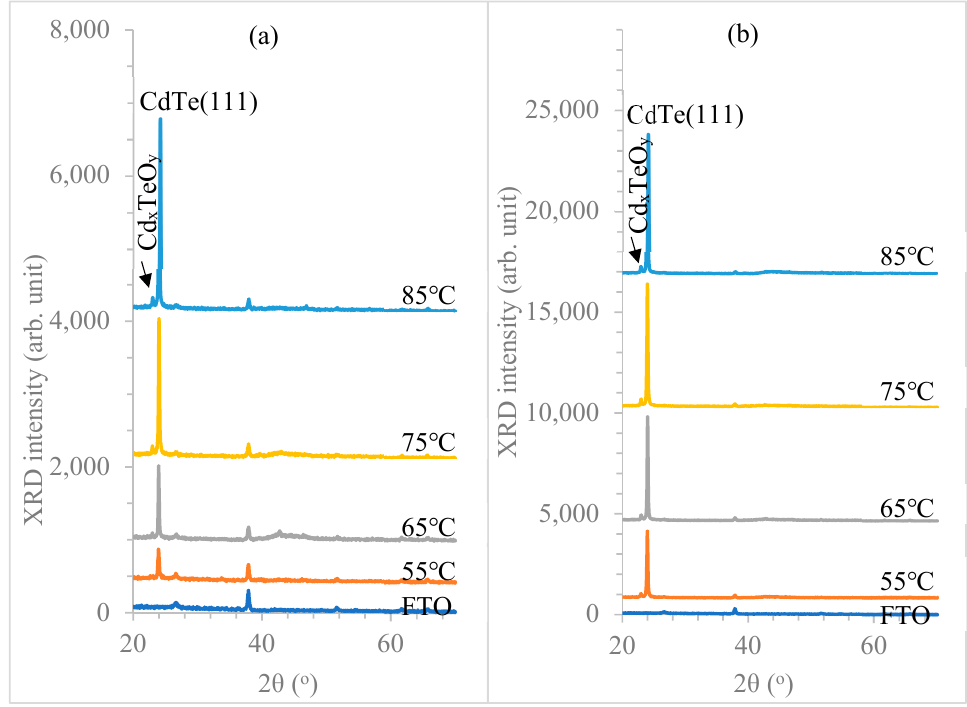
Figure 3. XRD patterns of CdTe thin-films electroplated at di ff erent temperatures under ( a ) as-deposited (AD) and ( b ) cadmium chloride treated (CCT)